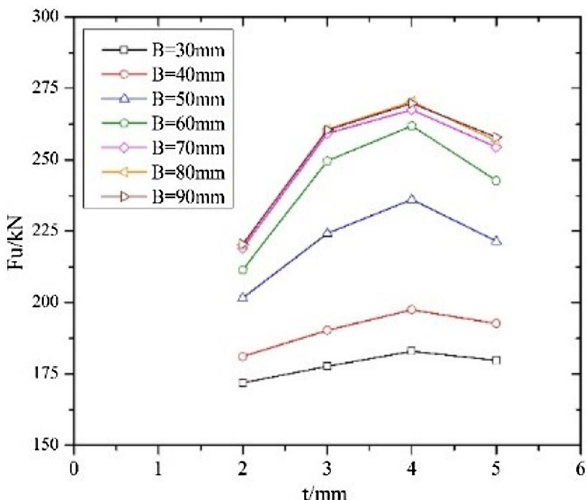
Fig. 18 Curves of F u – t relationship